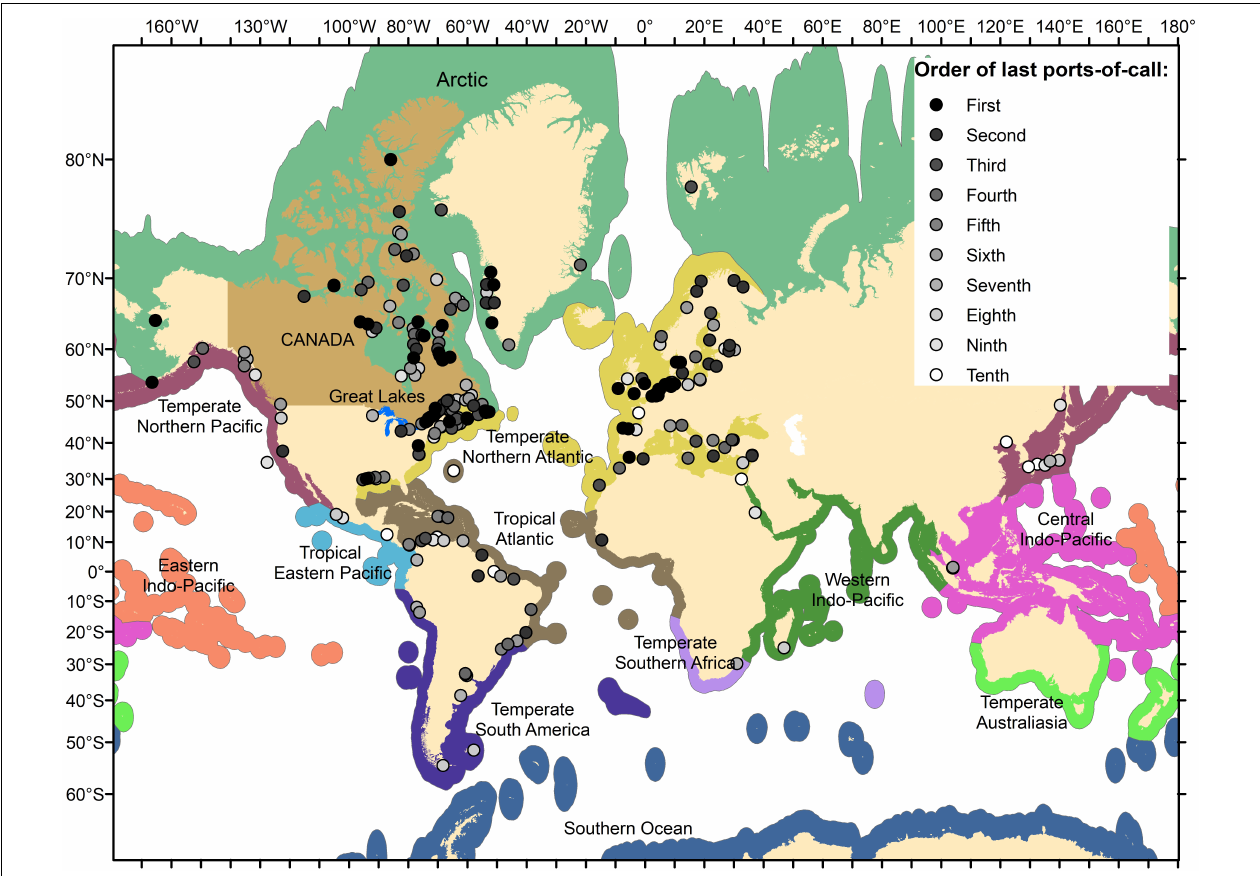
FIGURE 2 | Ports-of-call visited by respondent ships during the last 10 voyages preceding arrival at a Canadian Arctic port during 2015 and 2016, based on data collected from the questionnaire survey. The shade of the circle markers indicates the sequence of stops made by ships from the first - (most recent) last ports to the tenth-last ports. The Marine Ecoregions of the World biogeographic realms (and Laurentian Great Lakes) are shown as different colors in the